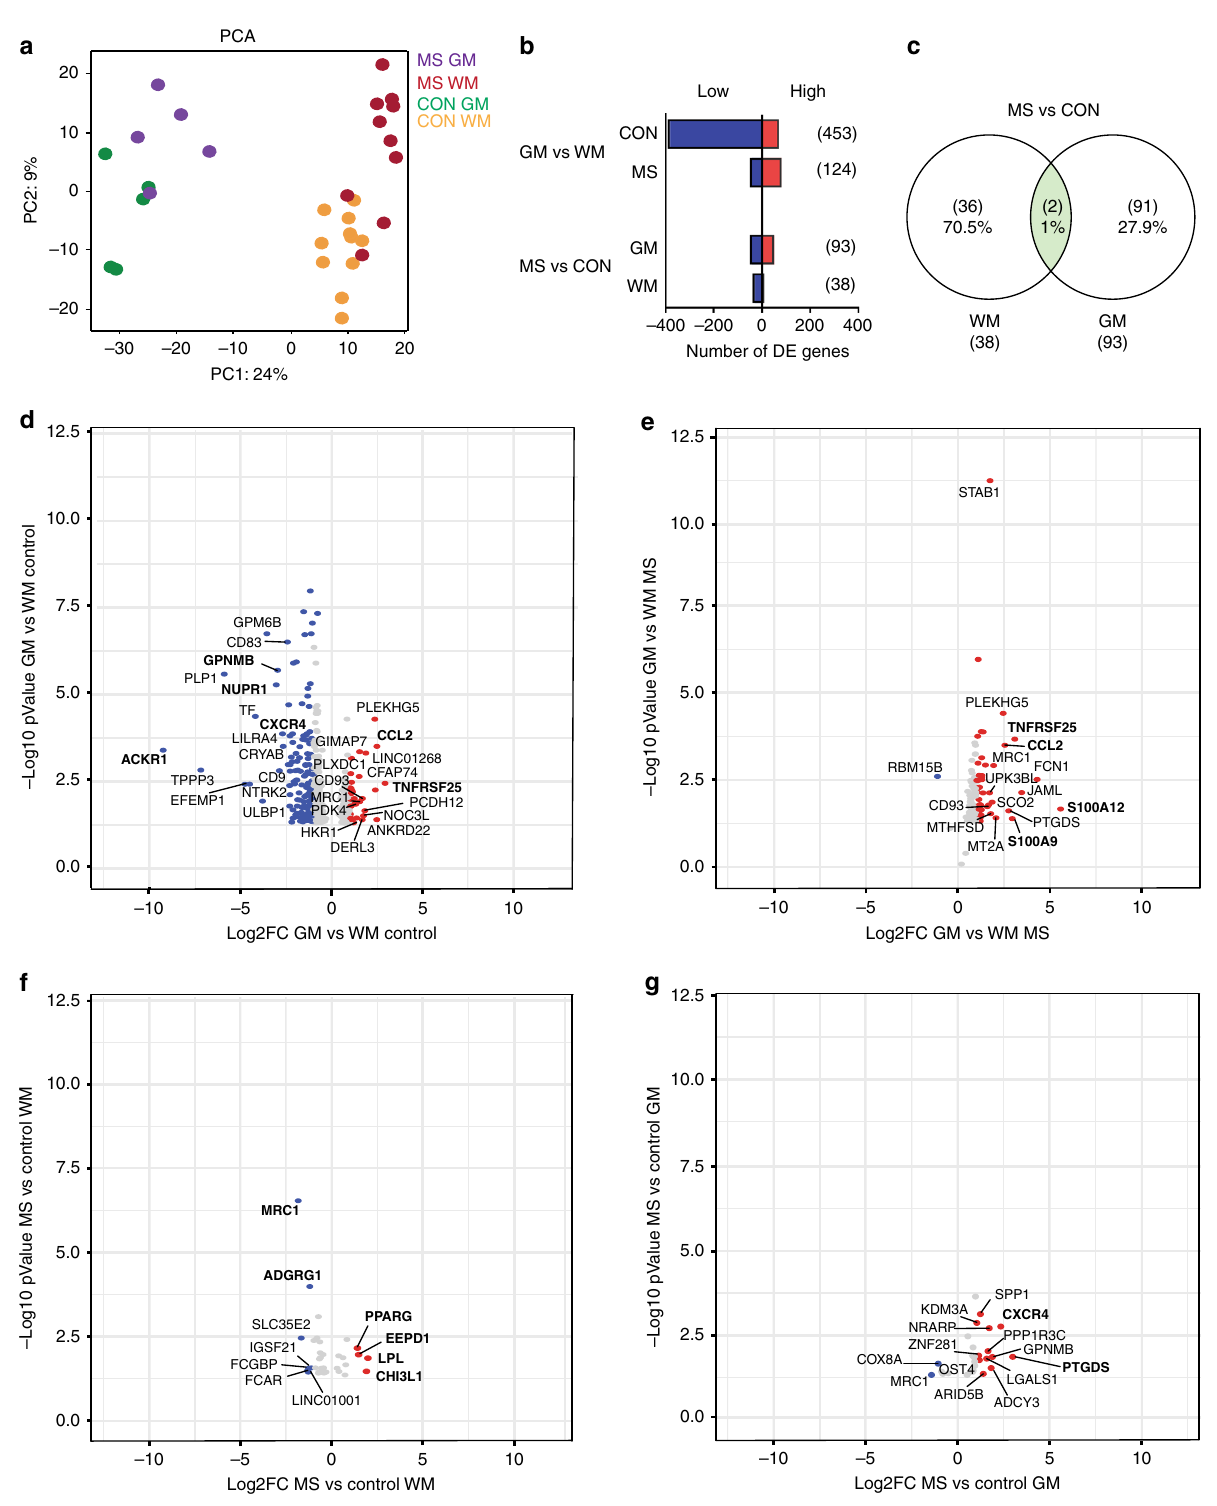
Fig. 2 Regional and multiple sclerosis (MS)-speci fi c changes in human microglia determined by differentially expressed (DE) genes. a Principal component analysis of global gene expression demonstrates profound differences between microglia from GM and WM and smaller differences between microglia from control and MS donors. b Number of DE genes for GM vs WM and MS vs CON, based on a fold change of > 2 or < − 2 and an adjusted p value (false discovery rate <0.05). c A Venn diagram shows hardly any overlap between GM and WM MS microglia, based on DE genes. The two overlapping genes are MRC1 and LOC101927481 . d – g Volcano plots illustrating the top regulated genes in GM vs WM microglia from control ( d ) or MS ( e ) and in MS vs control microglia in WM ( f ) and GM ( g ) regions. Red and blue dots indicate positive or negative fold change,